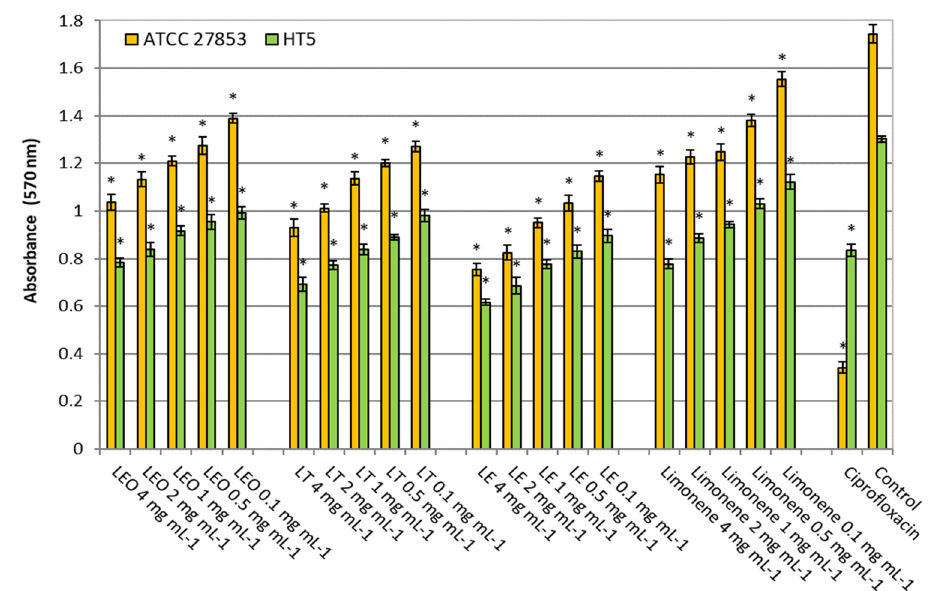
Figure 2. Metabolic activity of Pseudomonas aeruginosa strains into biofilm without (control) and in the presence of ciprofloxacin (5 µg mL − 1 ) or different lemon oils concentrations (0.1–4 mg mL − 1 ). LEO: Lemon Essential Oil, LF: Lemon Terpenes, LE: Lemon Essence. Asterisk indicates significant differences compared to the respective control (Tukey’s multiple range test, p < 0.05).